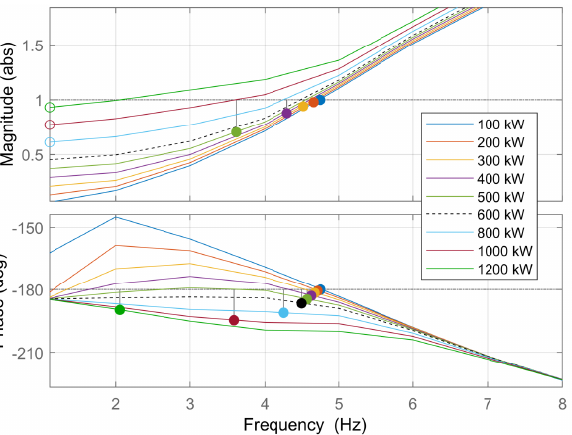
Figure 8. Bode diagram of system eigenvalue λ 1 for different levels of power consumption. Network Impedance: Z = Z s